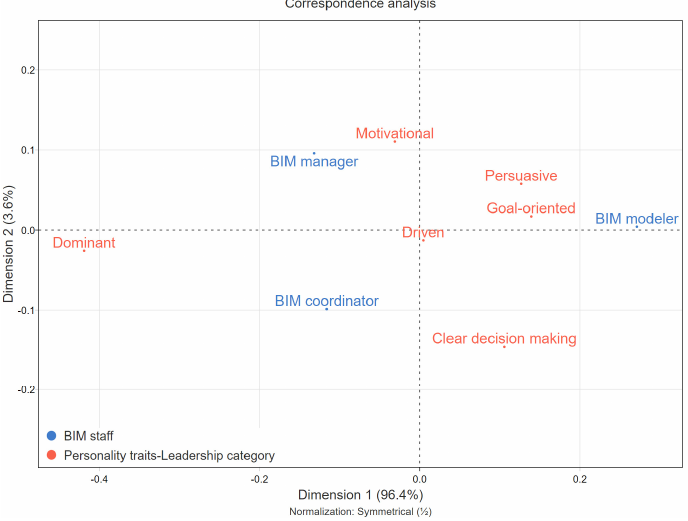
Figure 5. Comparison of the required degree of personality traits (leadership category) between BIM staff roles—Correspondence analysis.